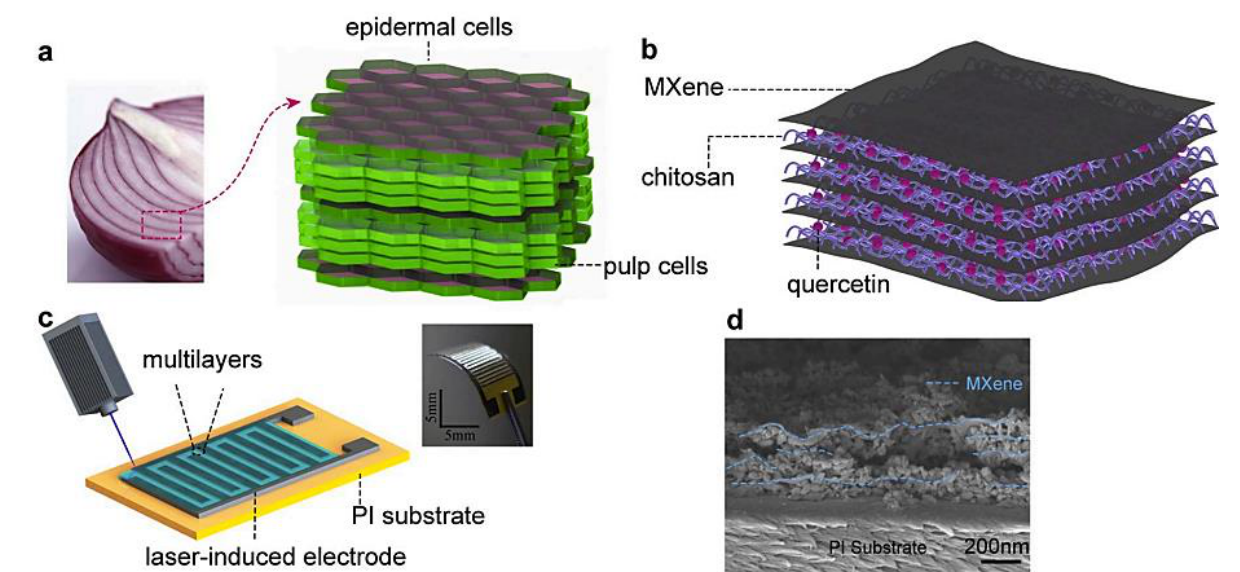
Figure 2. ( a – c ) The preparative process of onion-inspired MXene/chitosan-quercetin multilayers with their schematic structures for the designing of the flexible humidity sensor based on laser-induced interdigitated electrode upon polyimide (PI) substrate. ( d ) Cross-sectional scanning electron microscopy (SEM) that was obtained from the composites. Adapted from Ref. [64] with permission. Copyright 2020 Elsevier.